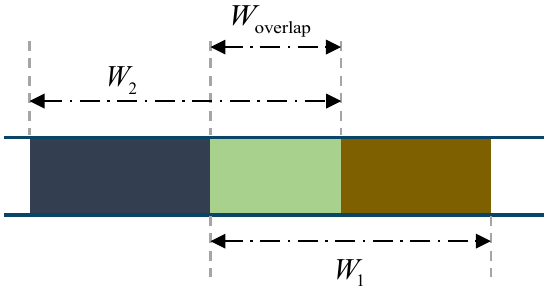
Figure 2. Utilization of overlaped frequency